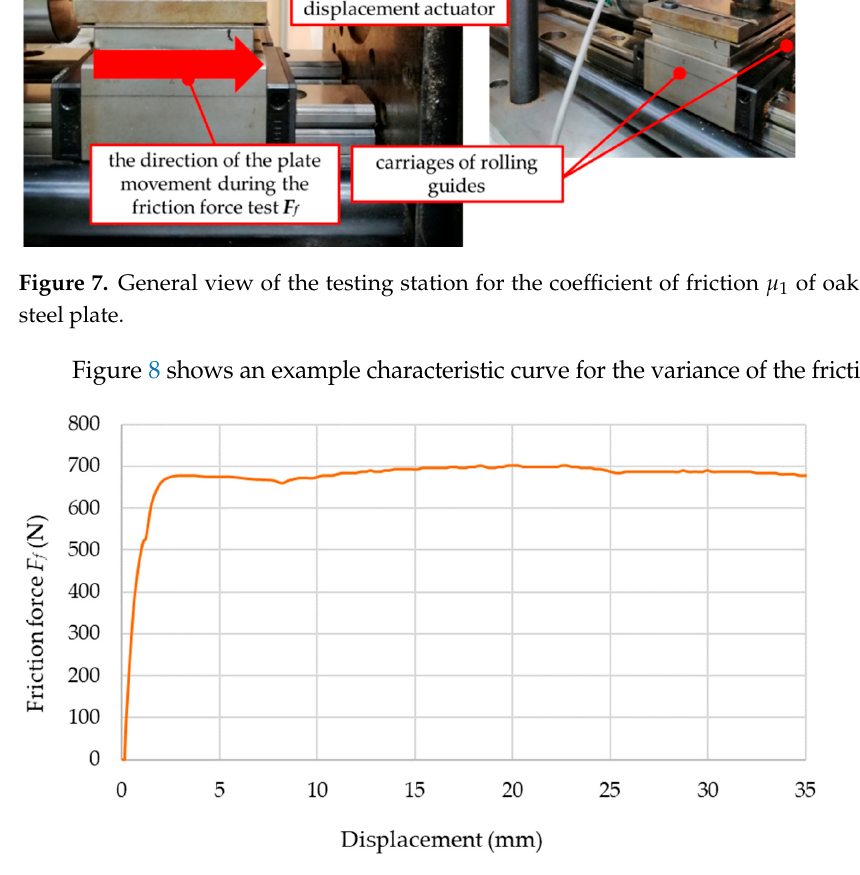
Figure 8. Example characteristic curve for the variance of the frictional force F f when compacting the sawdust with a force F = 20,000 N.